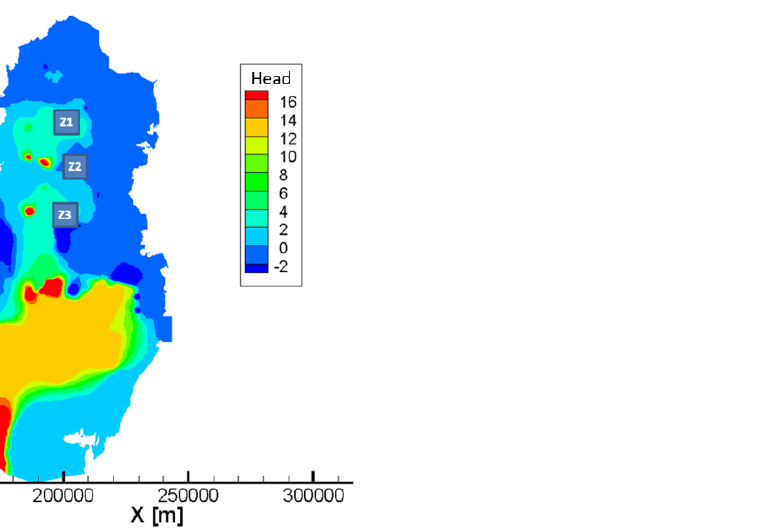
Figure 8. Infiltration well location and piezometric heads when the required volume of stored water is reached.